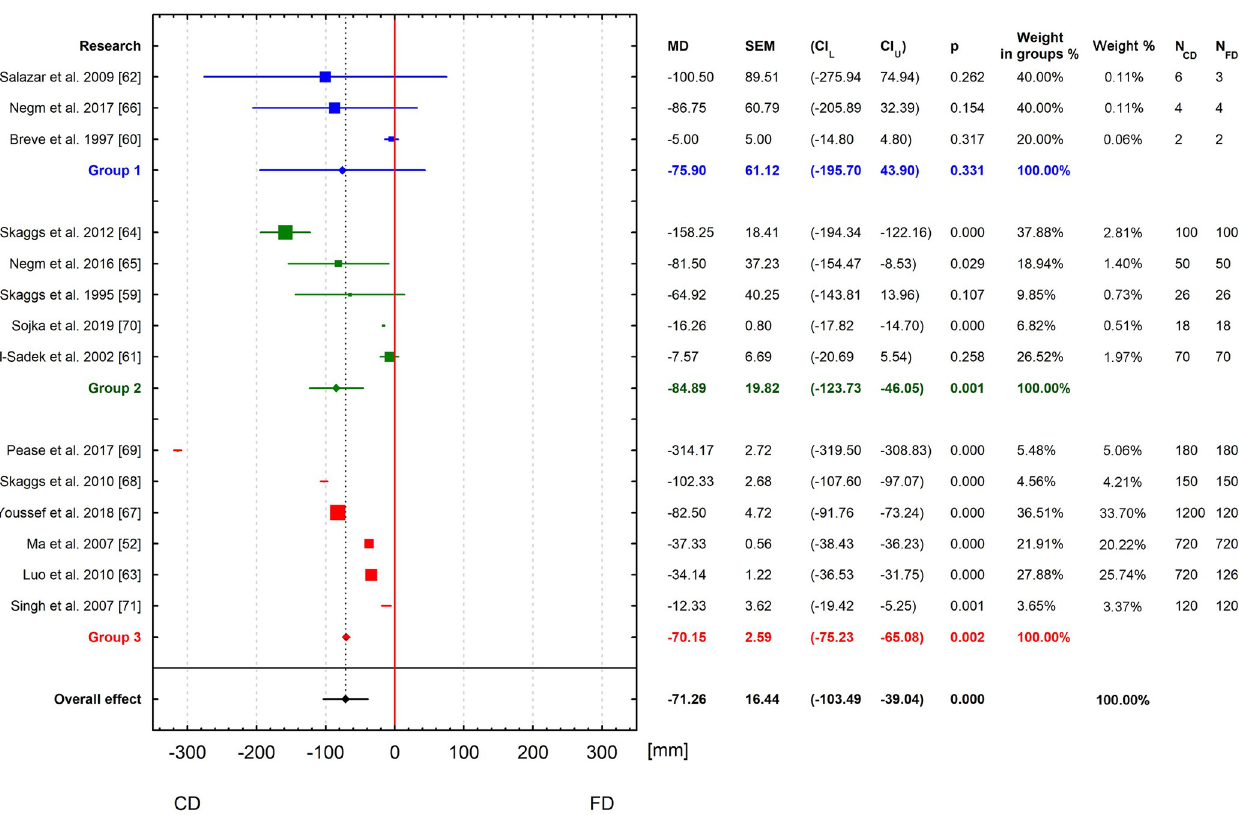
Fig 6. Meta-analysis in groups of subsurface drainage outflow reduction by CD versus